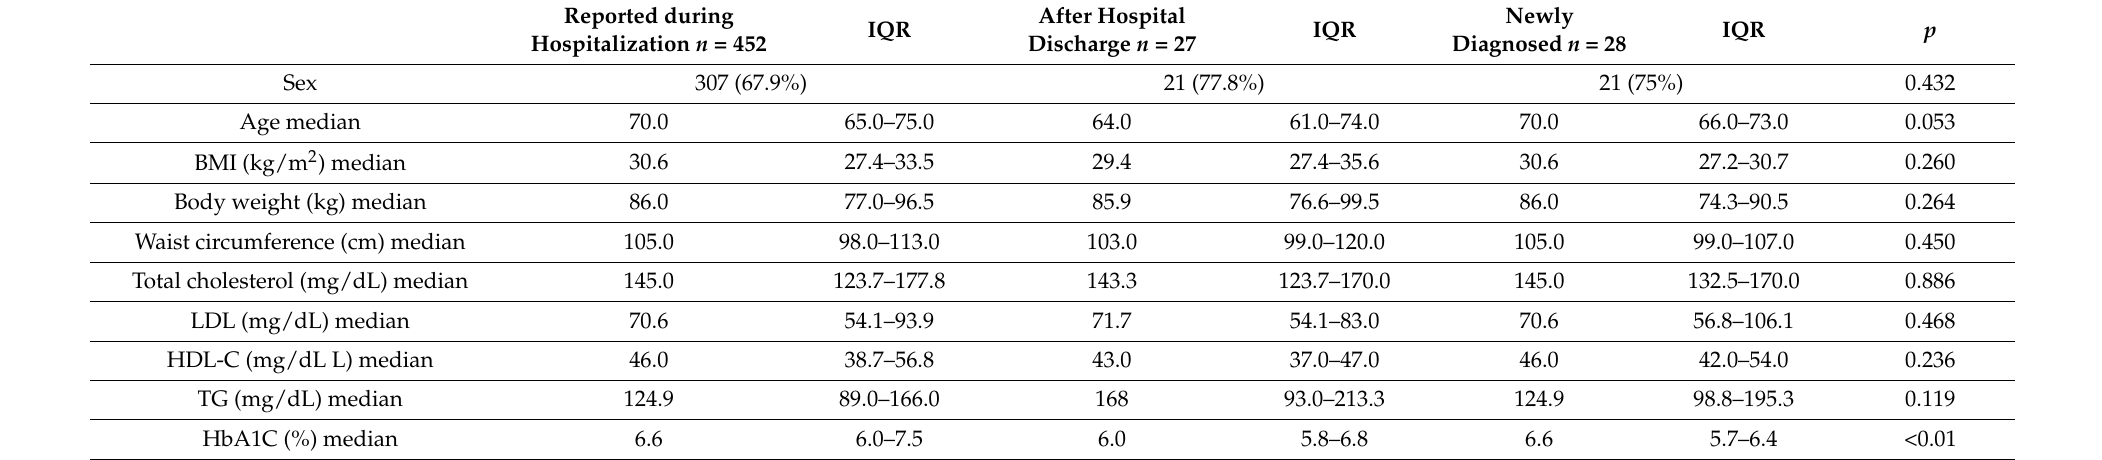
Table 4. Characteristics of all patients with